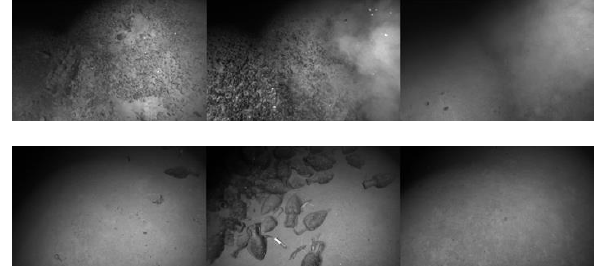
Figure 2. Samples of archaeological site #2 (top) and #8